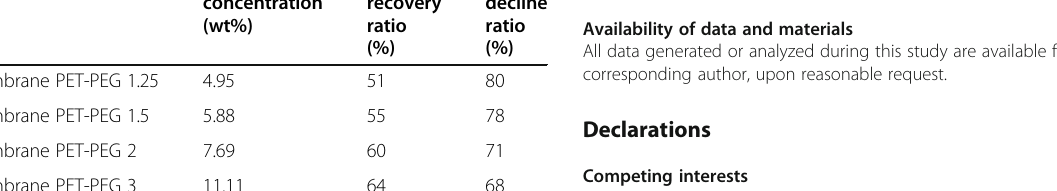
Flux Flux recovery decline ratio ratio (%) (%)